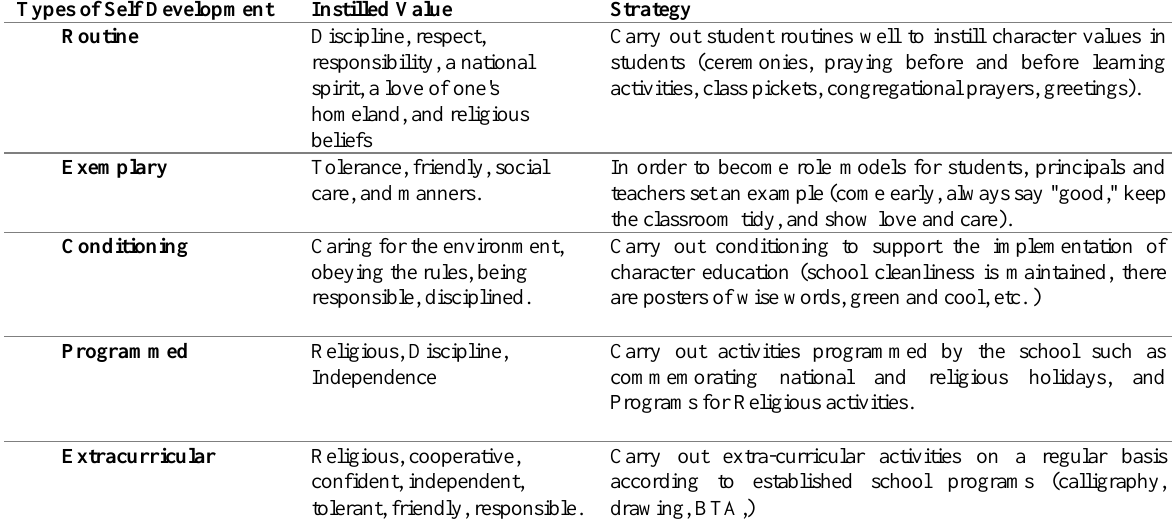
Table 1: Evidence of the kinds of